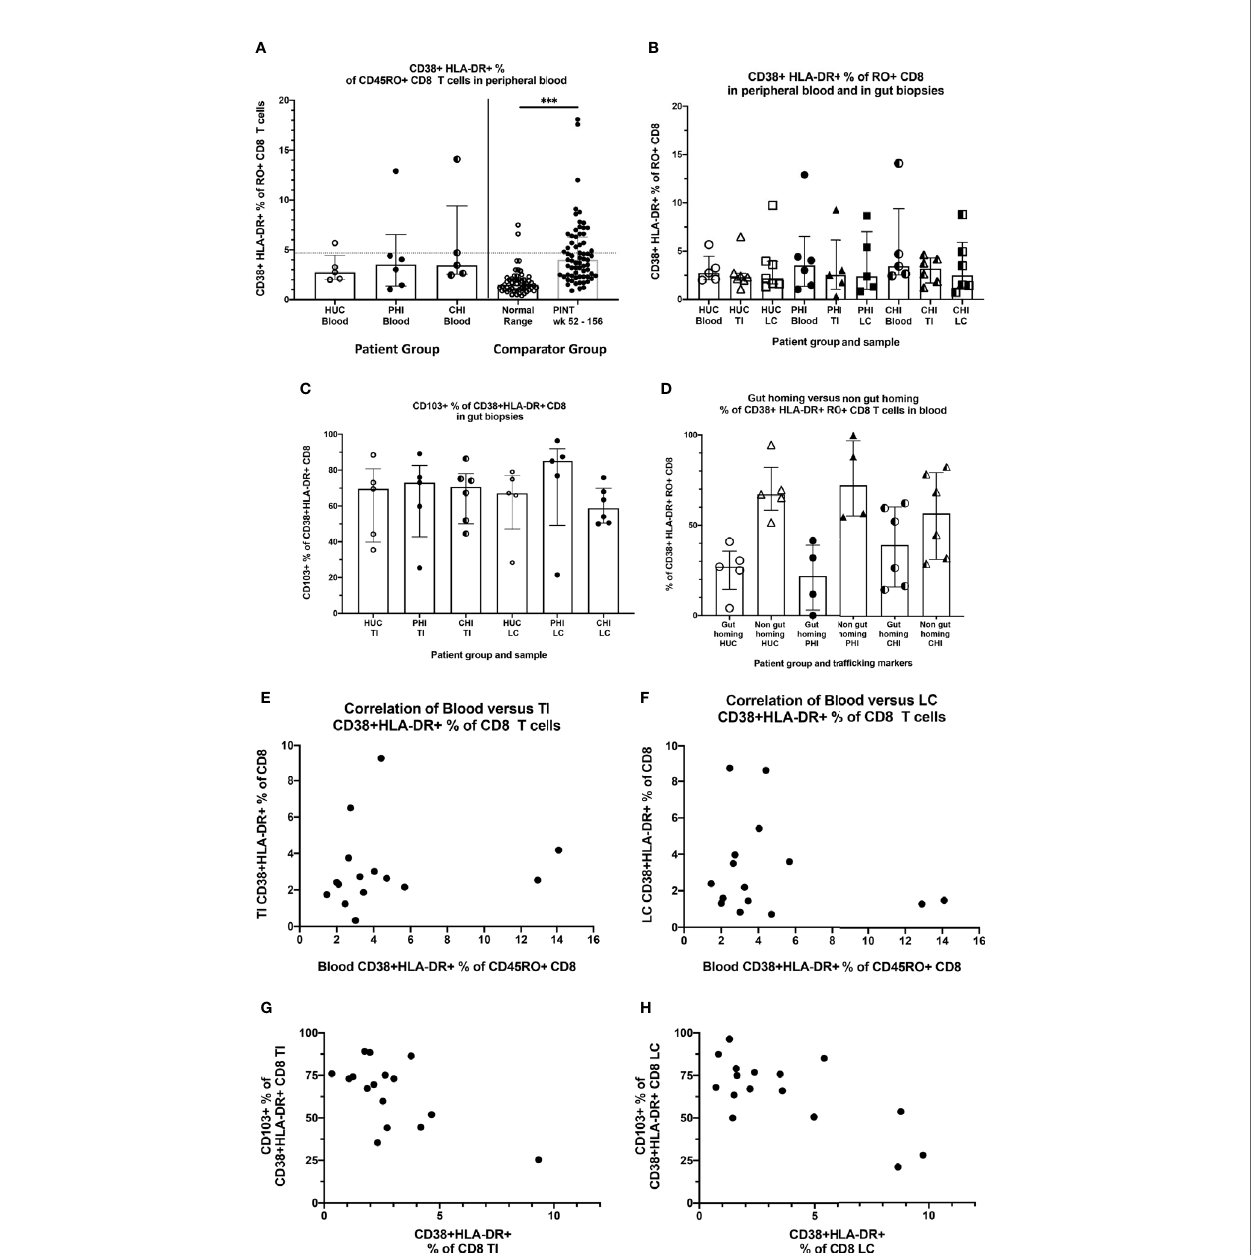
FIGURE 5 | Activated CD38+HLA-DR+ CD8 T-cells in blood and tissues. (A) Activated CD38+HLA-DR+ as % of CD45RA- CD8 T cells in peripheral blood, by study group. HUC, HIV-uninfected controls; PHI, HIV-positive patients treated during primary infection; CHI, HIV-positive patients treated during chronic infection. The Comparator Groups are (left) normal range for HUC subjects from reference (38) and the 95 th percentile (4.6%) is shown as the dotted horizontal line, and (right) PINT subjects longitudinal observations from reference (38). Statistical analysis between HUC, PHI and CHI groups was conducted using Kruskal Wallis one-way analysis of variance. Statistical analysis between comparator normal range and PINT groups was done using Mann-Whitney test. (B) Comparison of activated CD38+HLA-DR+ as % of CD45RA- CD8 T-cells in peripheral blood, TI biopsies and LC biopsies, respectively by study group. (C) Percentage of activated CD38+HLA-DR+ CD8 T-cells in TI and LC biopsies that are also CD103+. (D) Percentage of activated CD38+HLA-DR+ CD8 T-cells in peripheral blood that are either CD49d+integrin ß7+ gut-homing or CD49d+integrin ß7+-negative non-gut-homing, by study group. (E) Correlation of activated CD38+HLA-DR+ as % of CD8 T-cells in peripheral blood with activated CD38+HLA-DR+ as % of CD8 T cells in TI biopsies. (F) Correlation of activated CD38+HLA-DR+ as % of CD8 T-cells in peripheral blood with activated CD38+HLA-DR+ as % of CD8 T cells in LC biopsies. (G) Correlation of CD103+ as % of activated CD38+HLA-DR+ CD8 T-cells in TI biopsies with activated CD38+HLA-DR+ as % of CD8 T cells in TI biopsies. (H) Correlation of CD103+ as % of activated CD38+HLA-DR+ CD8 T-cells in LC biopsies with activated CD38+HLA-DR+ as % of CD8 T cells in LC biopsies. ***p <